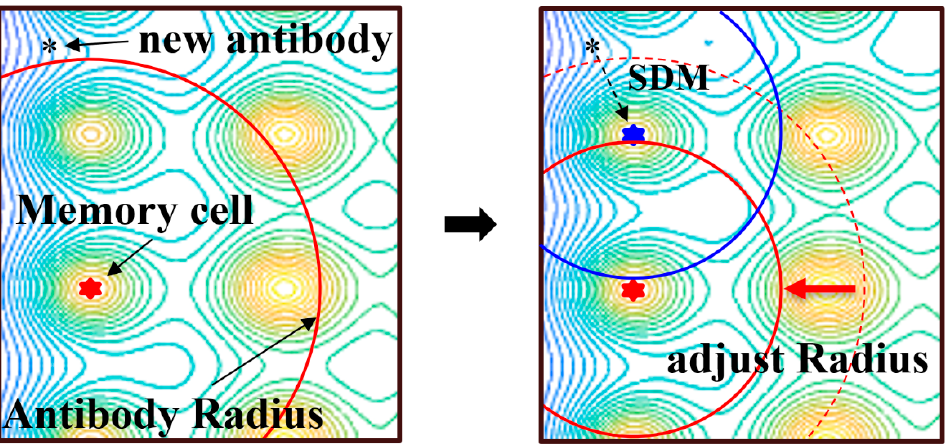
Figure 4. Conceptual schematic of the Novel Immune Algorithm (NIA) showing how the antibody radius is adjusted.